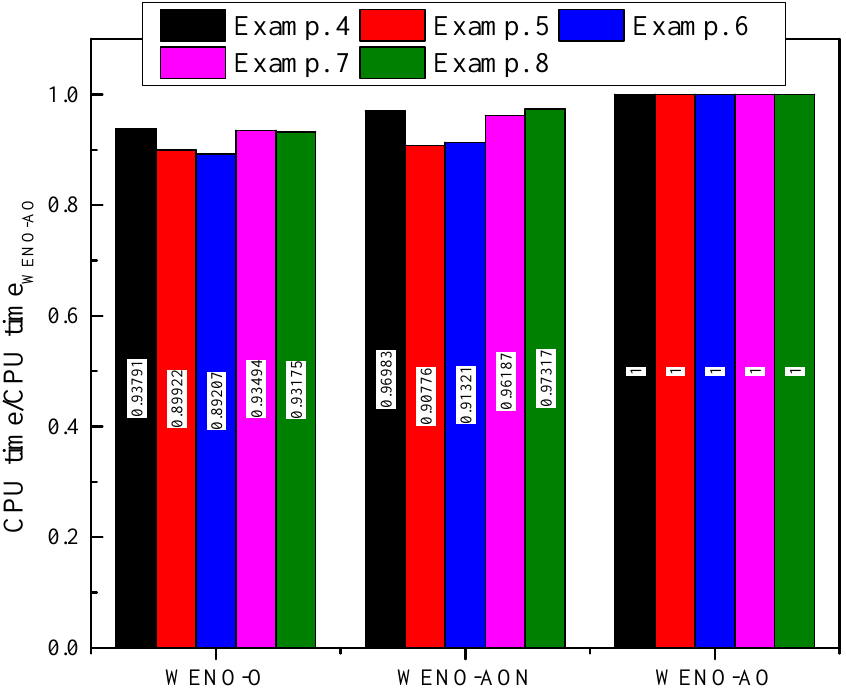
Figure 22. Comparison of CPU time of the adaptive order schemes (WENO-AO and WENO-AON) and proposed WENO-O scheme for six test